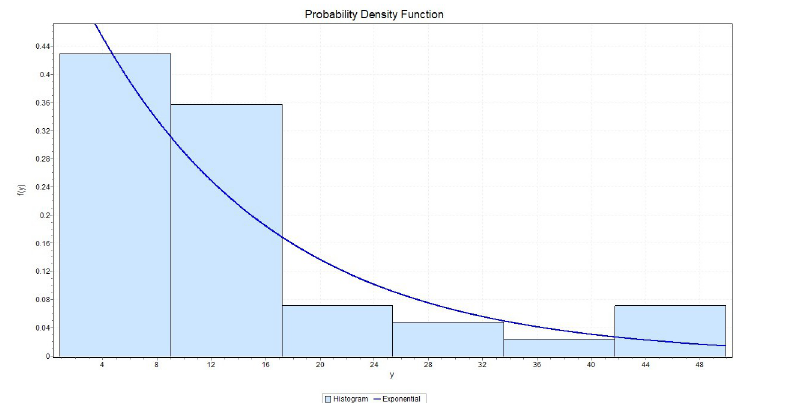
Fig 2. The histogram of the data set and its fitted density function to